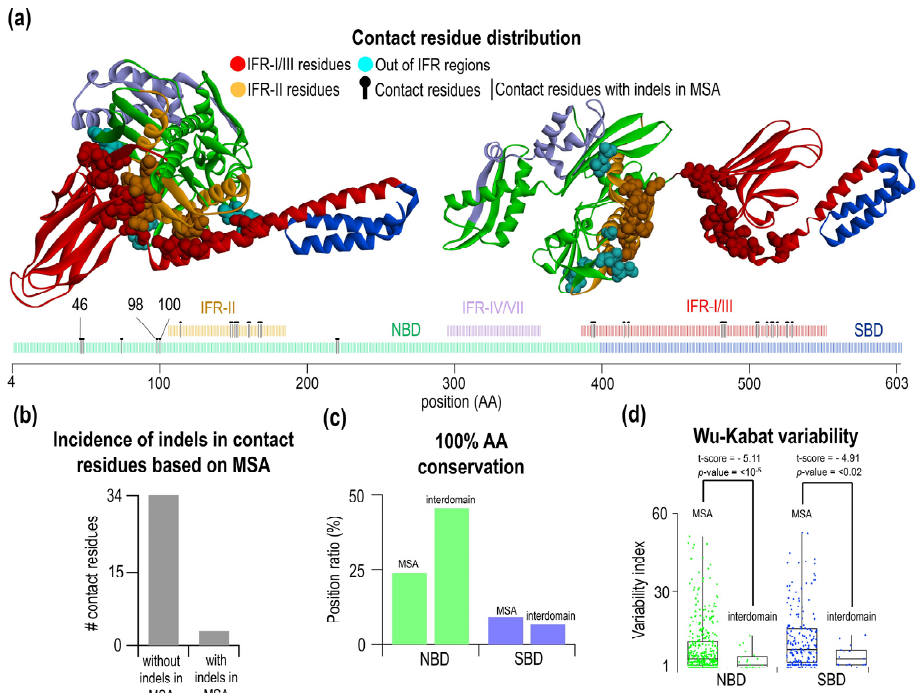
Figure 4. Characterization and analysis of contact residues. ( a ) Visualization of contact residues in the open (pdb: 4B9Q), closed (pdb: 2KHO) conformations, and schematic E. coli DnaK sequence. The contact is defined as a C α -C α distance < 7 Å of contact residues and with their conformation differences more than 2 Å. Totally, they are 37 residues in contacts. In three specific residues, a gap was found at the corresponding MSA positions. ( b ) Number of interdomain residues in the regions without or with indels. ( c ) Comparing of aa conservation of contacting interdomain residues with the whole MSA. The overall conservation of the NBD is 45.46% in interdomain contact residues compared to 24.01% in the whole MSA. ( d ) Comparing of Wu-Kabat variability of the interdomain residues in the NBD/SBD with the whole MSA. The average Wu-Kabat variability of MSA is 8.31% for NBD and 11.73% for the SBD. Interdomain contact residues had variability of 3.62% in the NBD and 5.33% in the